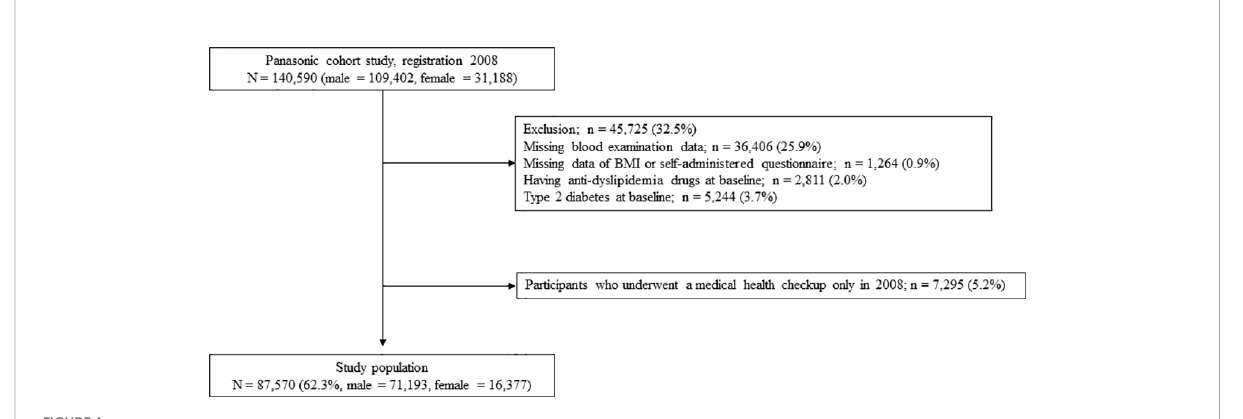
FIGURE 1 Study fl ow diagram for the registration of